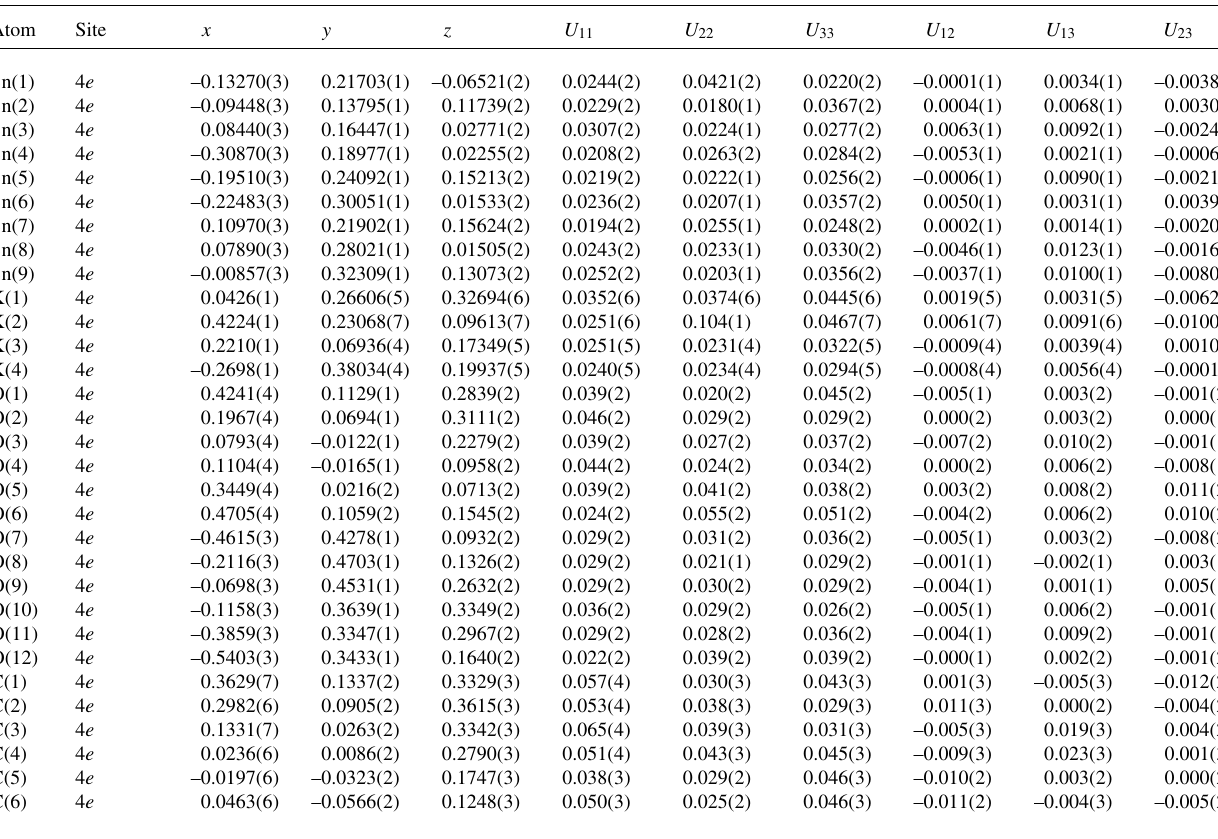
Table 3. Atomic coordinates and displacement parameters (in Å 2 ) .